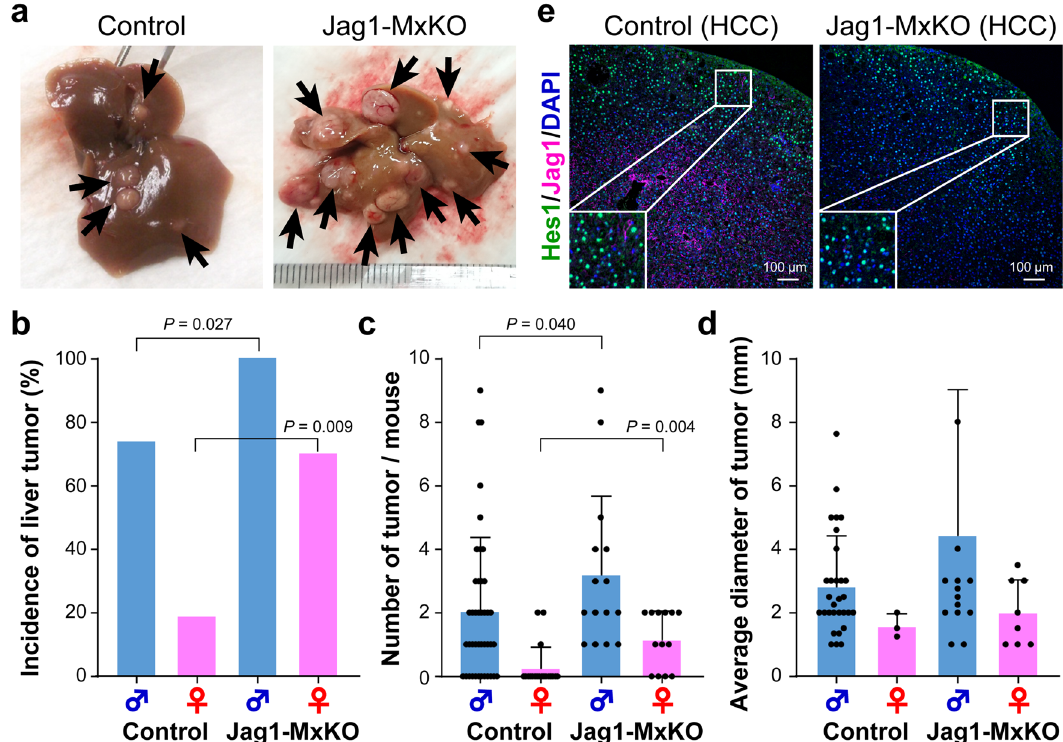
Fig. 4 Development of HCC induced by the deletion of Jag1 . a Representative macroscopic pictures of liver tumors observed in DEN-treated male control or Jag1 conditional knockout mice (Jag1-MxKO). Arrows indicate the tumors observed on the liver surface. The histograms show the incidence of development of tumors ( b ), the mean number of tumors ( c ), and the average size of tumors ( d ) observed in the control and Jag1-MxKO male and female mice. The values represent the mean ± SD from the control (42 males and 19 females) and Jag1-MxKO (15 males and 11 females) mice. e Excised HCC specimens were subjected to immuno fl uorescent co-staining using anti-Hes1 ( green ) and anti-Jag1 antibodies ( magenta ) together with DAPI nuclear staining ( blue ). Scale bar, 100 μ m.